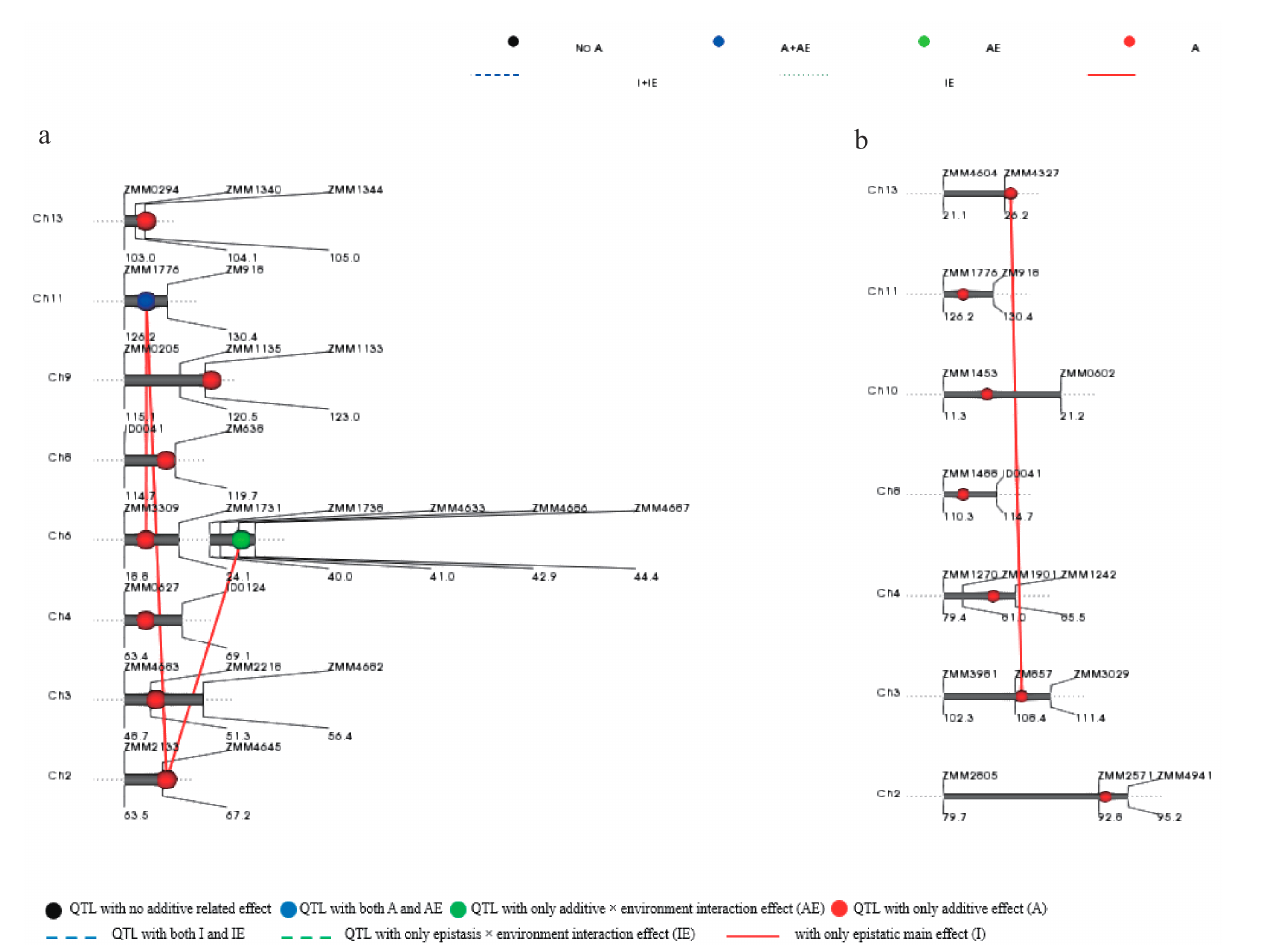
Figure 3. Network of epistatic QTLs for sesamin ( a ) and sesamolin ( b ) on LG2, LG3, LG6, LG11 and LG13 in RIL population detected by QTLNetwork 2.1.